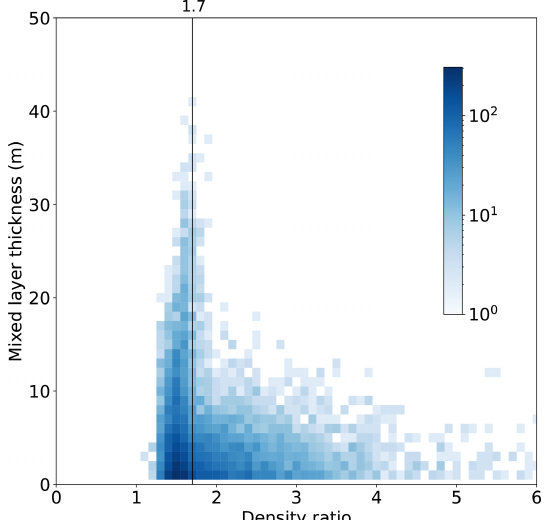
Figure 11. Masks shading the conditions in Fig. 10. Red areas mask where the conditions are not met. Grey blocks are the location of thermohaline mixed layers; black blocks are mixed layers thicker than 10m. Glider data from the tropical North